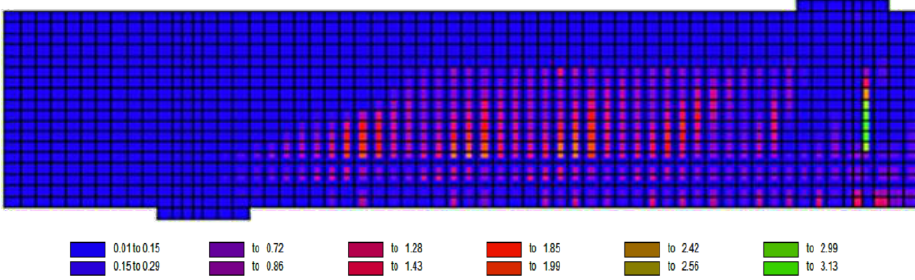
Figure 23. Numerical Crack Width (Pattern) and Failure Mode of Specimen (S3-EB).